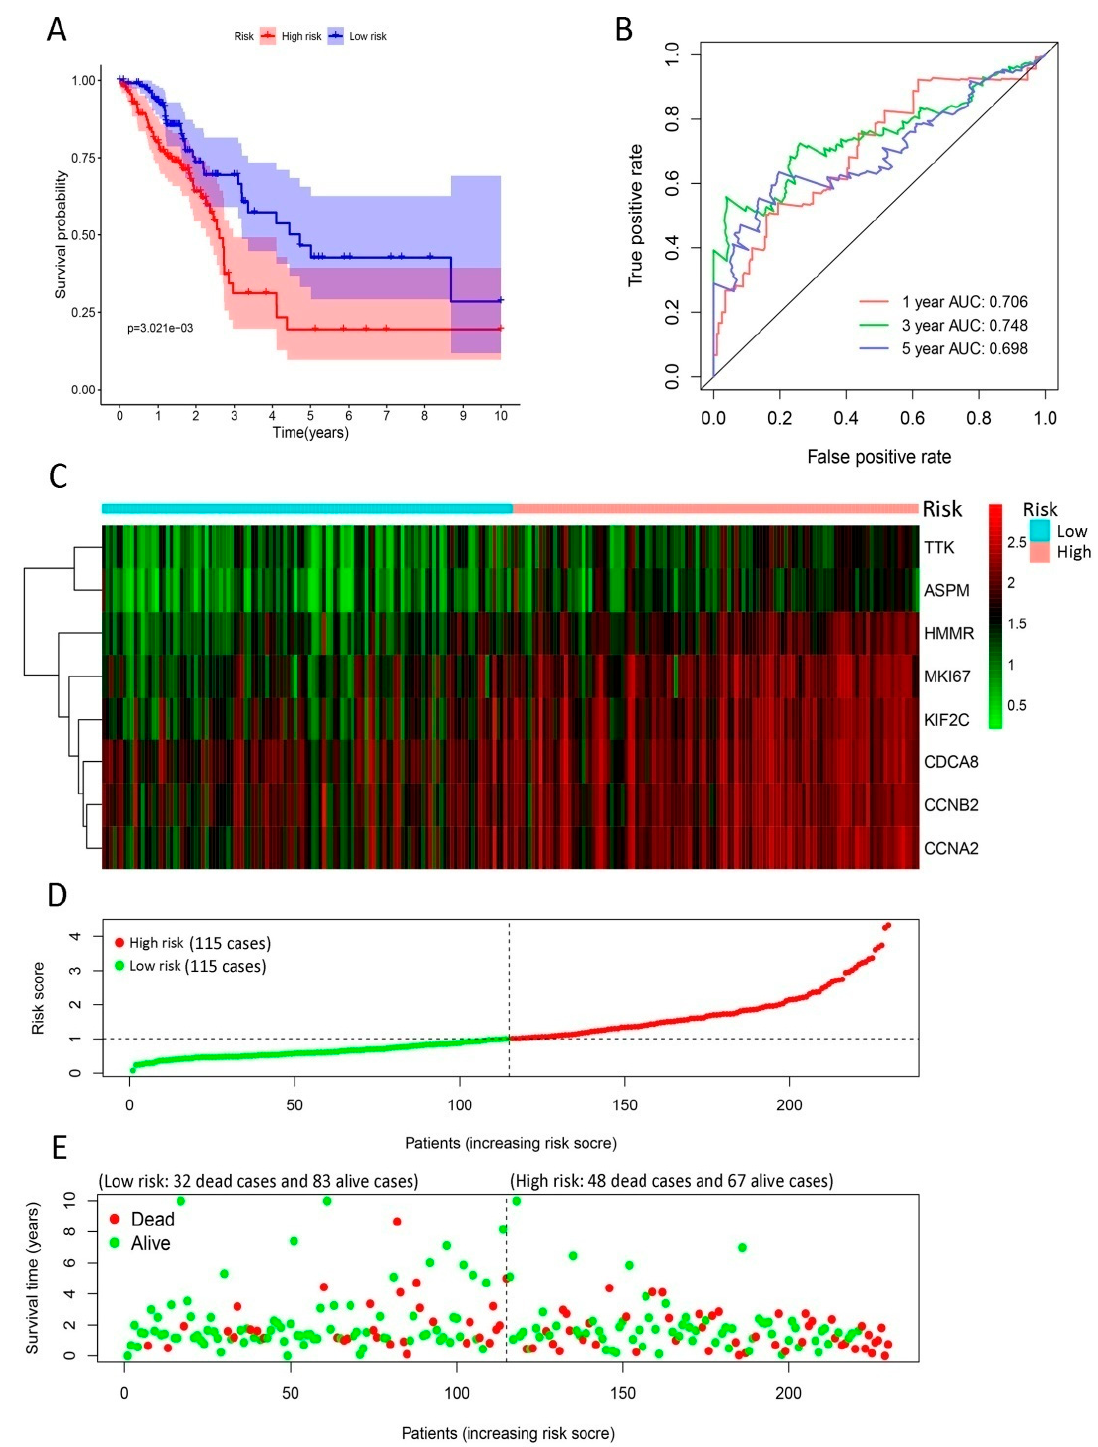
Figure 4. Development of gene signature in the training group. ( A ) Survival curves of high- and low-risk groups separated by gene signature. ( B ) Receiver operating characteristic (ROC) curves for survival risk predicted by gene signature for 1-, 3-, and 5-year follow-ups. ( C – E ) Expression heatmap of eight signature genes ( C ), risk score distribution ( D ), and survival status of patients ( E ). The risk score based on gene signature appears to be correlated with survival status for lung cancer patients in low- and high-risk groups.